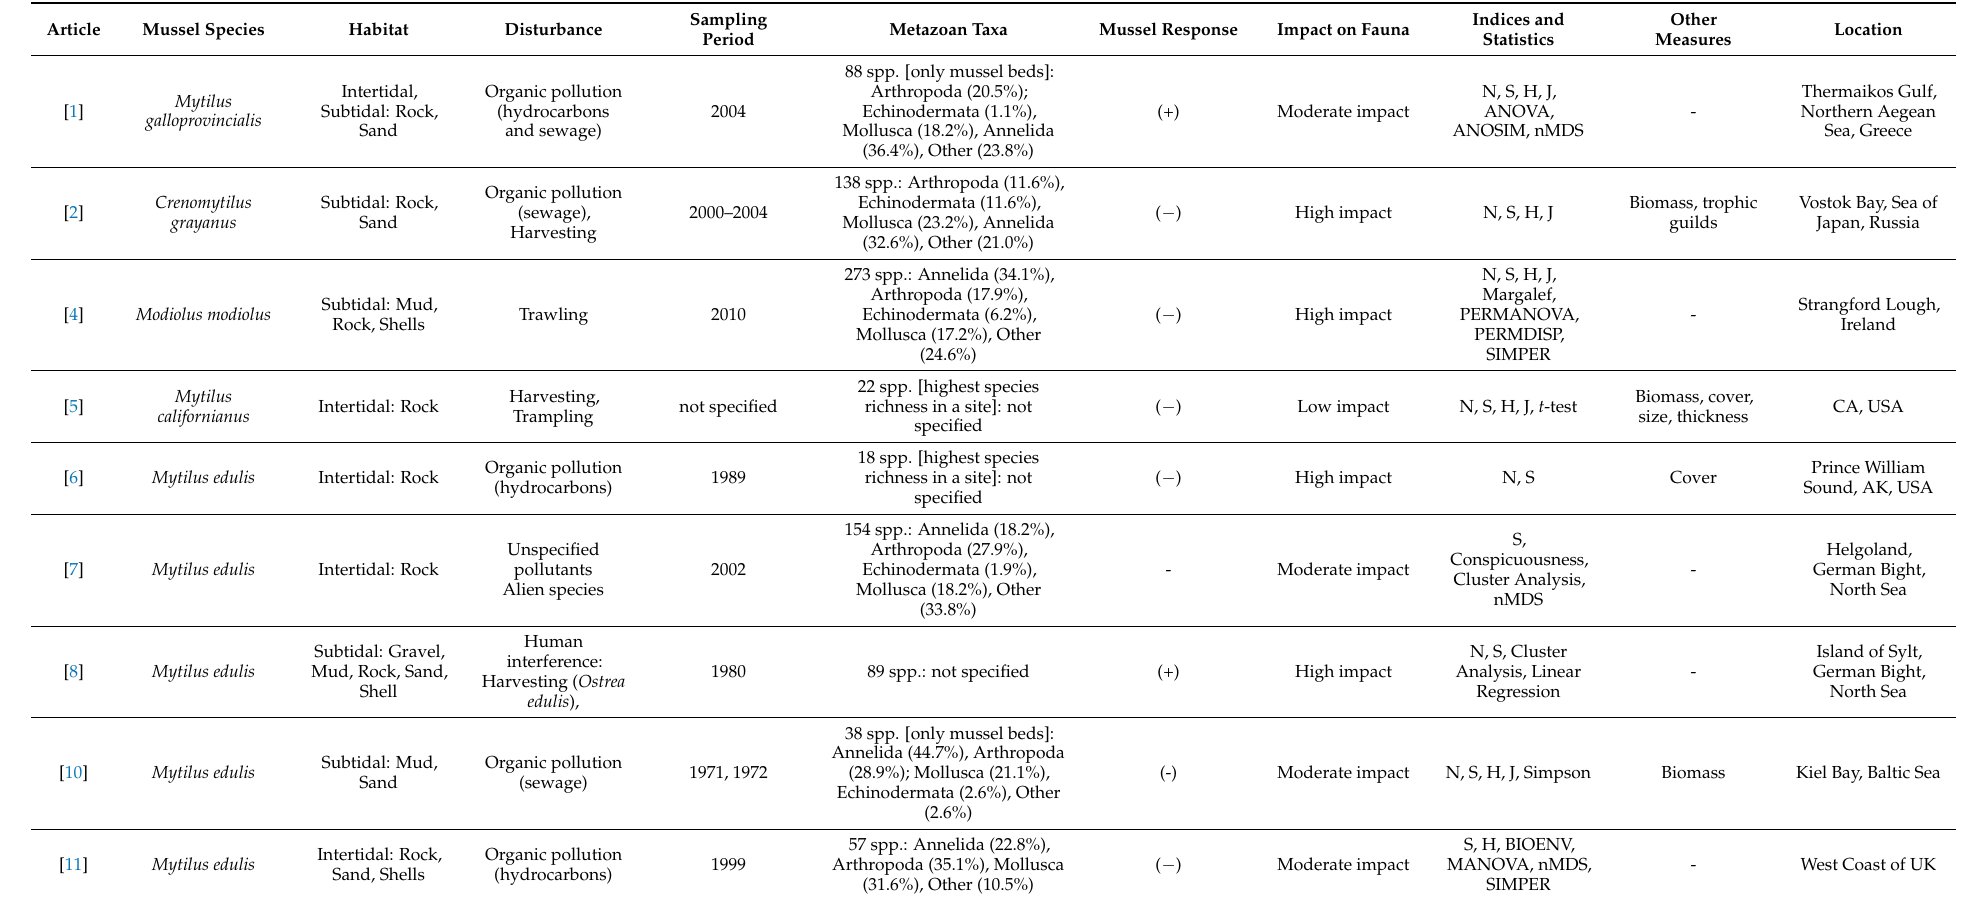
Table 1. Reviewed anthropogenic disturbances that impacted mussel beds and associated assemblages. spp. = species; N = abundance; S = species richness; H = Shannon–Wiener’s diversity index; J = Pielou’s evenness index; ANOSIM = analysis of similarities; ANOVA = analysis of variance; BIOENV = best subset of environmental variables; MANOVA = multivariate analysis of variance; nMDS = non-metric multidimensional scaling; PERMANOVA = permutational analysis